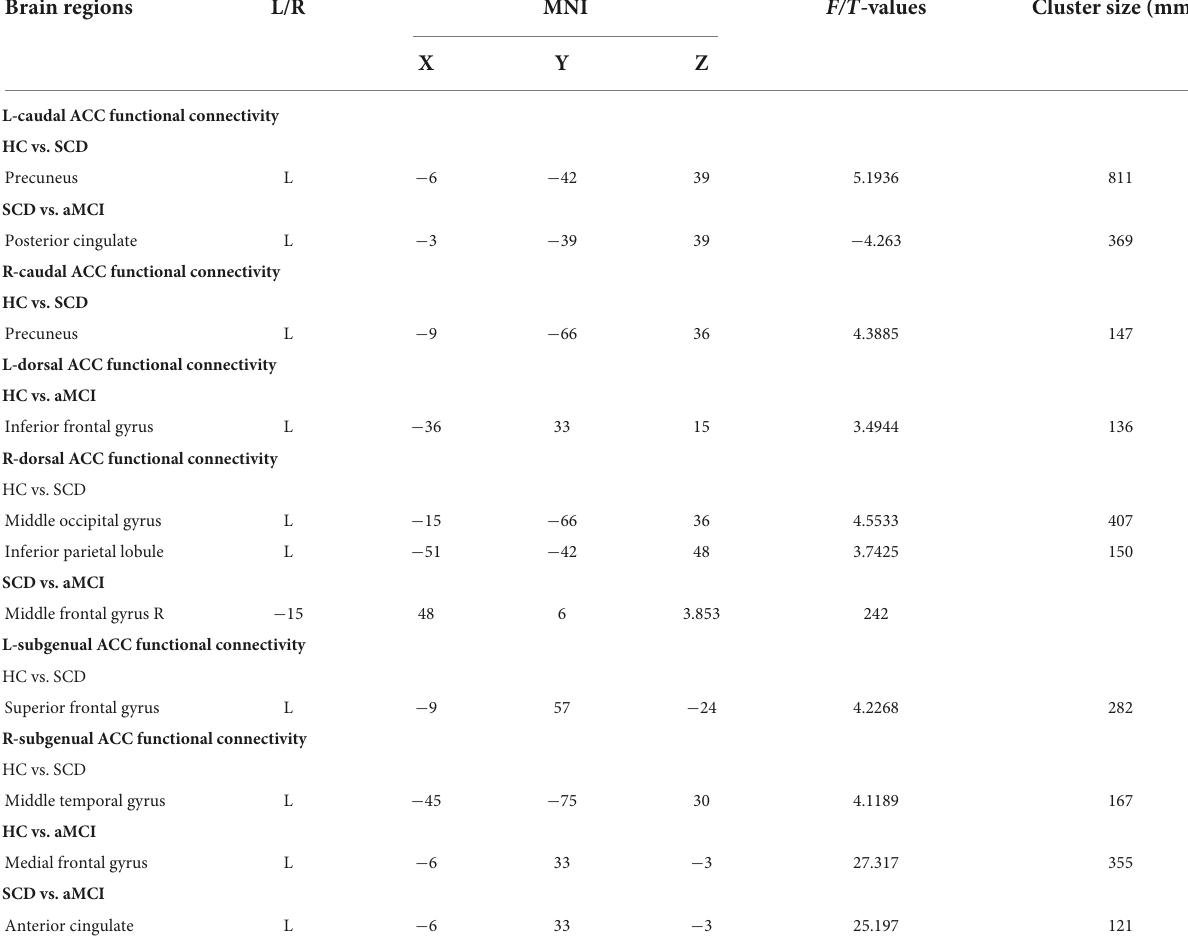
TABLE 3 Comparisons of functional connectivity of anterior cingulate cortex subregions. Brain